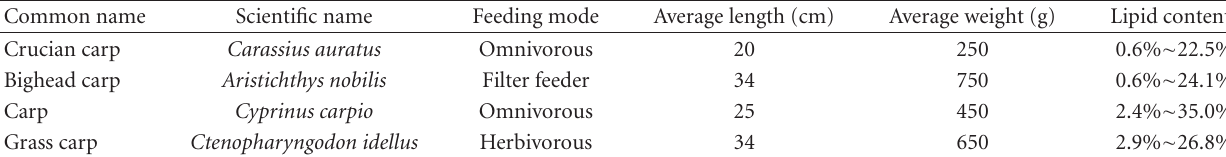
Table 1: Fish species and their characteristics collected from a local market in